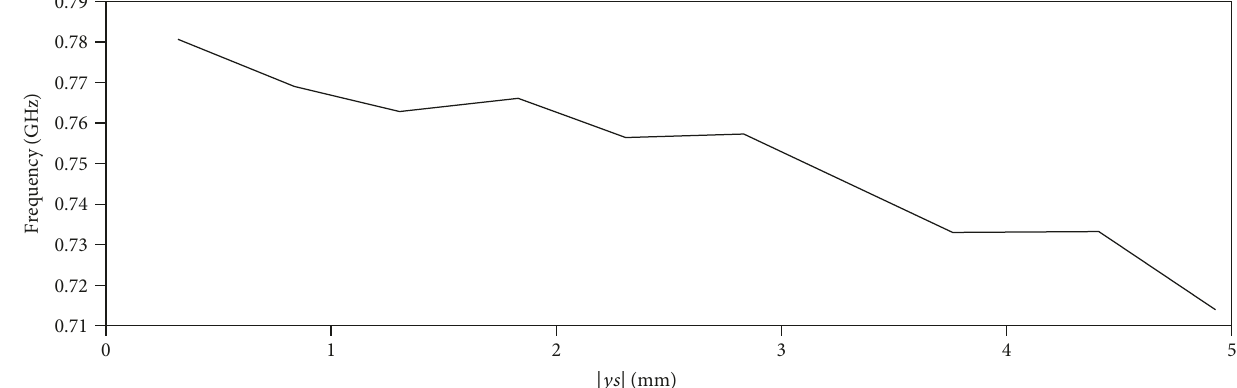
Figure 8: Simulation results for the resonant frequency dependence of the shorting post location y